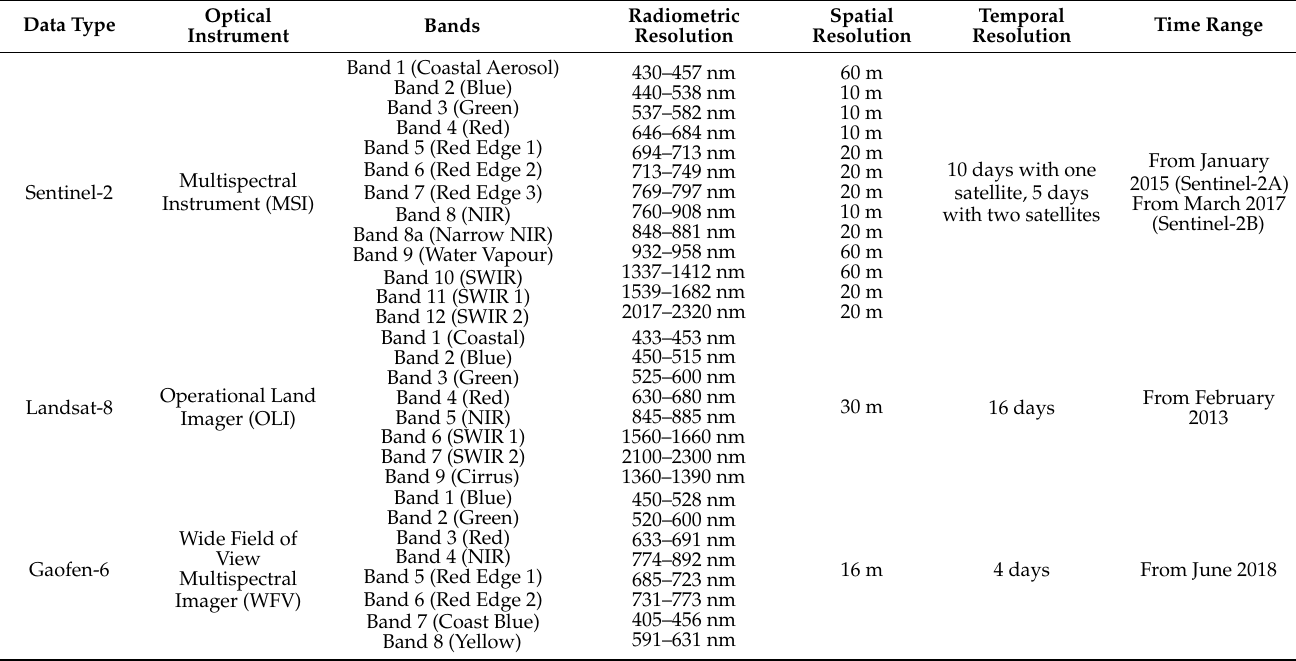
Table 2. Major parameters of three open-access satellite